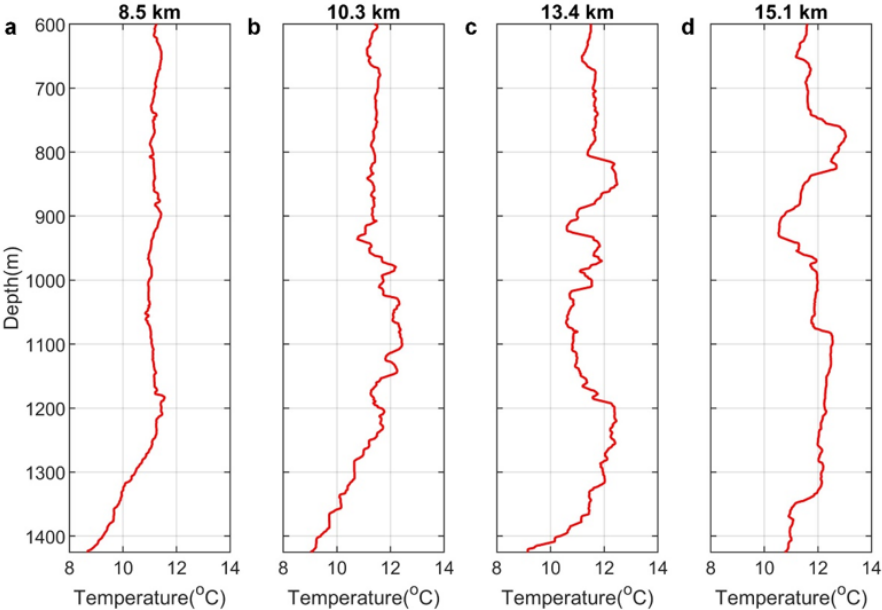
Figure 10. The temperature versus depth of XBT ( a ) 6, ( b ) 7, ( c ) 8 and ( d ) 9. Their locations on the meddy can be found in Figure 7. The depth range is 600 m to 1400 m, which is consistent with the meddy depth range.